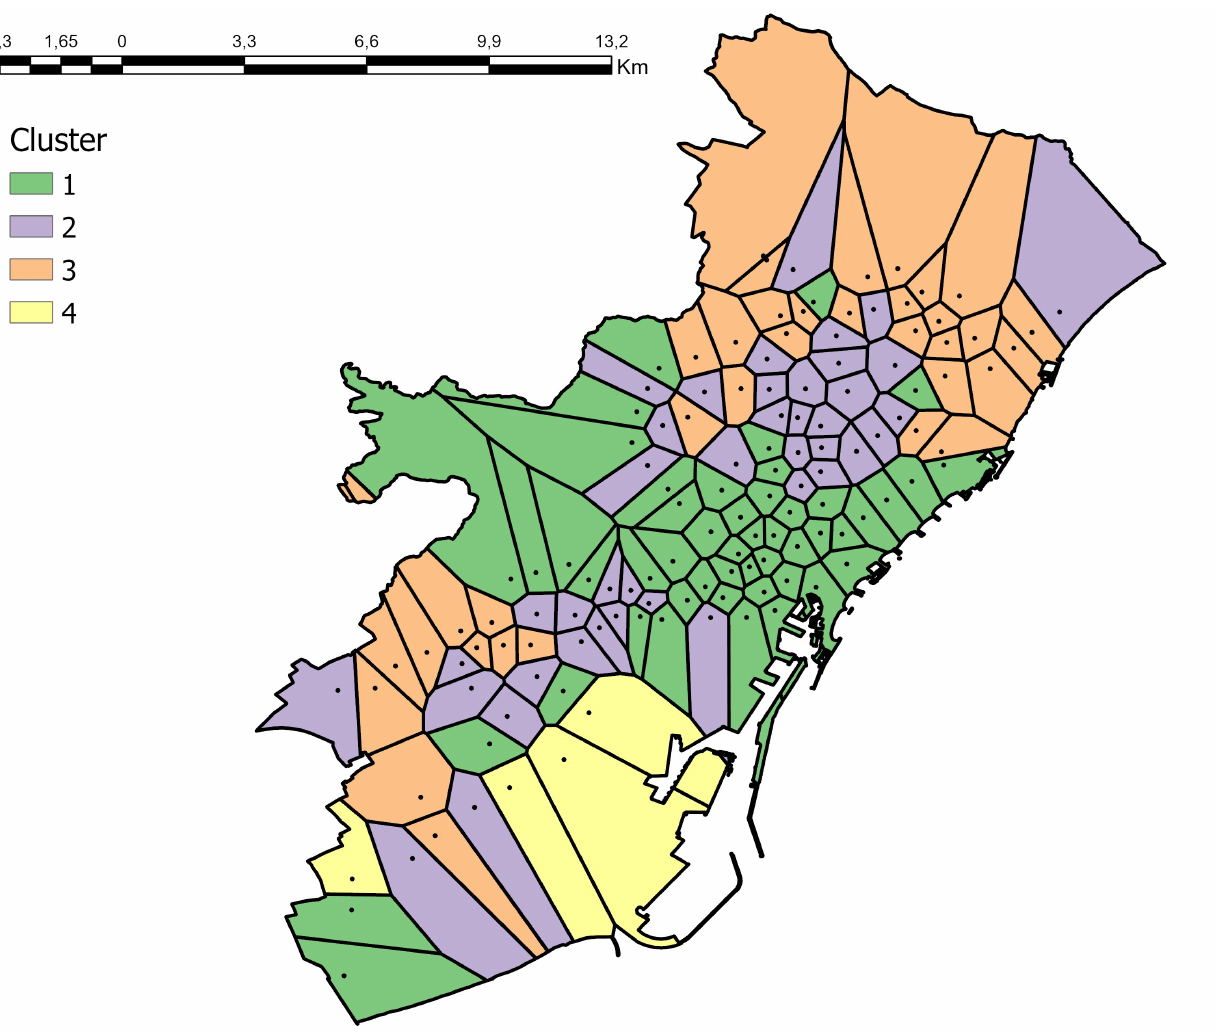
Figure 12. Map of the different stations colored by cluster